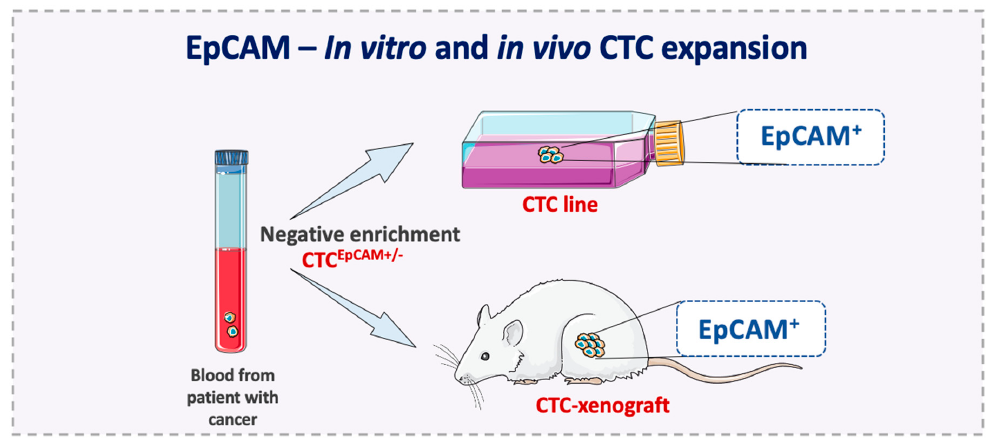
Figure 2. In vivo and in vitro CTC expansion. In vitro and in vivo models are essential to identify and characterize metastasis-competent CTCs. The successful expansion of this more aggressive subset of CTCs after negative selection showed a clear EpCAM-positive phenotype in different studies from independent research groups [105–109,112,113].